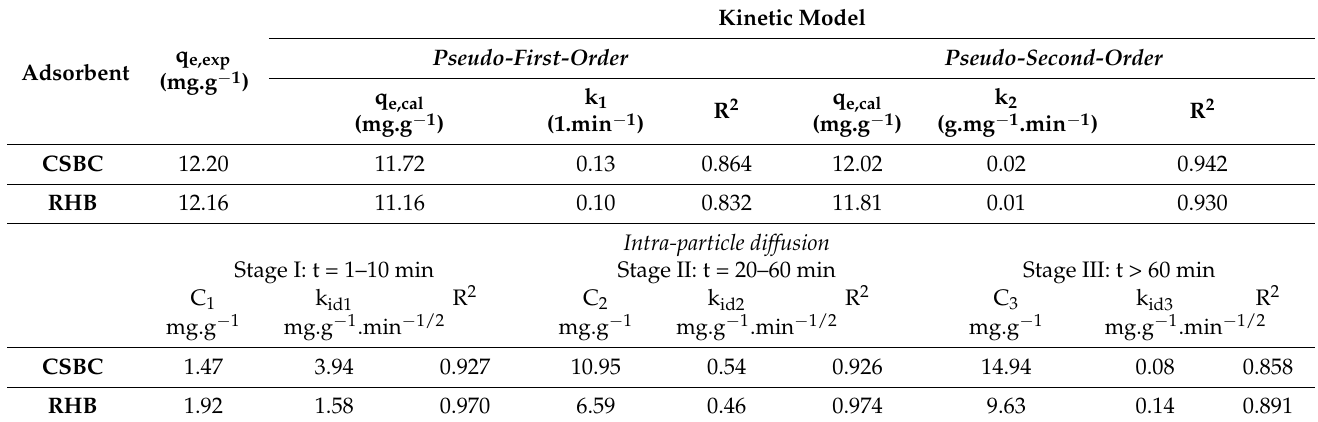
Table 2. Fitting results of different kinetics for MO Adsorption by RHB and CSBC.